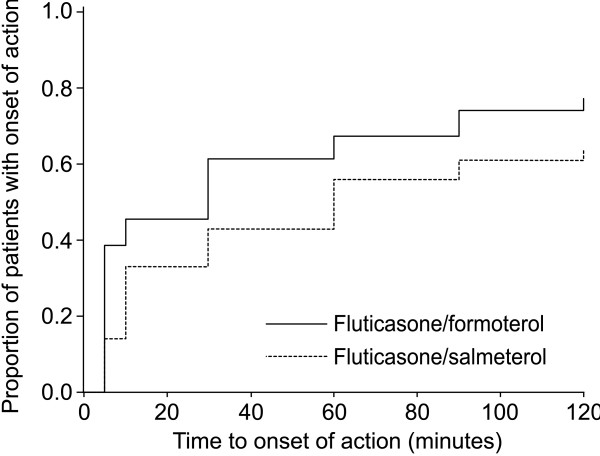
Time to onset of action of study medication at baseline (day 0; similar plots were obtained at weeks 2, 6 and 12). Data based on Kaplan-Meier survival analysis (full analysis set). Onset of action was defined as the first time point post-dose at which FEV1 was at least 12% greater than the pre-dose value. Analysis of time to onset of action using the multiple failures time model showed superiority of fluticasone/formoterol over fluticasone/salmeterol (hazard ratio: 1.64; 95% CI: 1.28, 2.10; p < 0.001). On day 0, more than twice as many patients had a bronchodilatory response that met the onset of action criterion in the fluticasone/formoterol group than in the fluticasone/salmeterol group at 5 minutes post-dose (39% versus 14%, respectively). In addition, a larger proportion of patients in the fluticasone/formoterol group met the onset of action criteria within 2 hours (post-dose), than in the fluticasone/salmeterol group (77% versus 64%, respectively; day 0). This trend continued over the 12-week treatment period, with consistently more patients achieving the predefined onset of action response in the fluticasone/formoterol group than in the fluticasone/salmeterol group at each post-dose time point (5–120 minutes). CI, confidence interval; FEV1, forced expiratory volume in the first second.